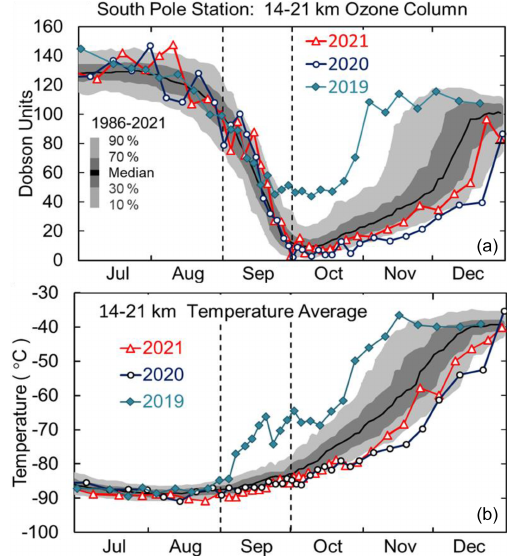
Figure 3. Ozonesonde July–December time series in 2019–2021 showing the 14–21km column ozone in Dobson units (DU) (a) and average temperature (b) compared to the 36-year median (black line) with gray percentile envelopes. The dramatic polar vortex dis- ruption in September 2019 versus cold and stable conditions in 2020 and 2021 shows the extreme variability in September to November measurements that eventually all converge to normal ozone values and temperatures by the end of December.